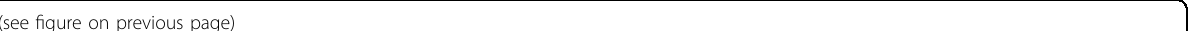
(see fi gure on previous page) Fig. 4 Molecular interactions among cell types and the regulatory potentiality from epidermal/mesenchymal cells to dendritic cells during psoriasis. A Chord plot visualization of the ligand-receptor interactions among cell types. The de fi ned cell types were indicated outside of each bend. Arc line between each cell types represented the ligand to receptor interactions, and the color indicated the ligand expressed cell types. B Chord plot visualization of the ligand-receptor interactions between top scored resident cell types and type 1 DC. The de fi ned cell types were indicated outside of each bend. Arc line between each cell types represented the ligand to receptor interactions, and the colors indicated the ligand expressed cell types. C Sankey plot visualization of the interactions from the ligand of mesenchymal type cells to the receptors of type 1 DCs. The IL- 17B/IL-17RB pair was highlighted as red. D Immuno fl uorescence staining of the epidermis/dermis junction of human skins, PDGFRB protein was stained as red, IL-17B as green, and DAPI as blue, the cellular co-expressions of PDGFRB and IL-17B were observed at the dermis layer close to the junction (pointed by white arrow) and at the layer junction. Scale bar, 100 µM. E , F Immunohistochemistry staining and quanti fi cation of PDGFRB ( E ) and IL-17B ( F ) in healthy and psoriatic skins. Host IgG of primary antibodies were used as negative control. In dermis layer, the average PDGFRB protein amount didn ’ t signi fi cantly change ( E ), but IL-17B protein signi fi cantly increased in psoriasis ( F ). Scale bar, 100 µM. Ctrl N = 6; Psor N = 10. **, p < 0.01. G , H The secreted protein levels of CXCL8, CCL20, IL-6, IL-1B, and IL-17B in skin fi broblasts ( G ) or skin basal cells ( H ) under TNF- α treatment were determined by ELISA. The protein concentrations were normalized to control group. N ≥ 3; *, p < 0.05; NS not signi fi cant. i Flow cytometry histograms of CD80 and CD86 expressions in DCs induced by IL-17B. LPS treatment was used as positive control.